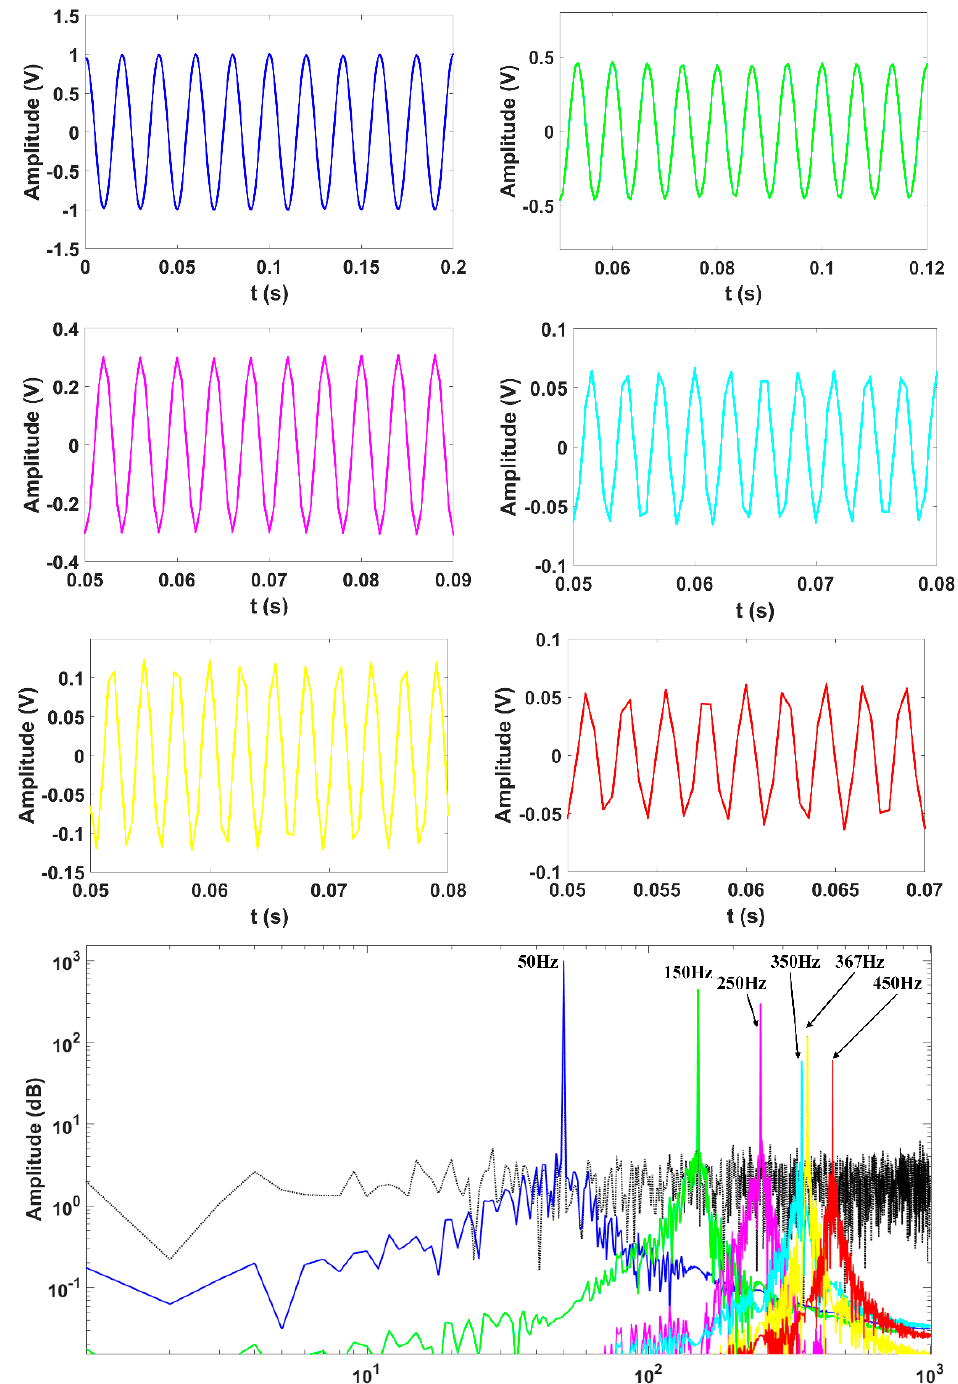
Figure 3. The decomposed modes and their frequency spectrum.